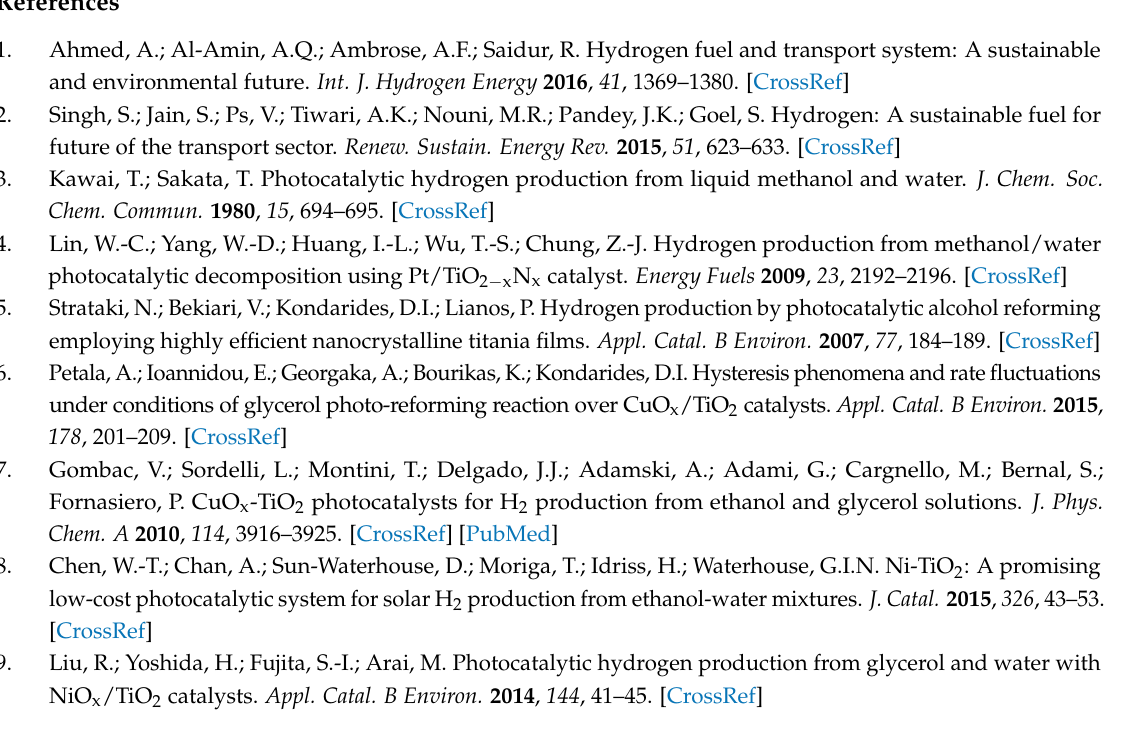
Figure S1: Close view of (0 0 1) main reflection on the prepared catalysts, Figure S2: XPS survey spectra of NTO, NTO/Ni/Pt and NTO/Pt/Ni samples, Figure S3: Kubelka–Munk spectra of Na 2 Ti 3 O 7 bare and deposited with Ni and Pt metals, Figure S4: Time dependent hydrogen evolution over NTO/Pt/Ni sample, Figure S5: XPS characterization of the sample with the best performance (NTO/Pt/Ni) post reaction, Figure S6: EDX mapping analysis of the NTO/Pt/Ni sample after photocatalytic test, Table S1: Semi-quantitative analysis of XPS peaks of bi-metallic